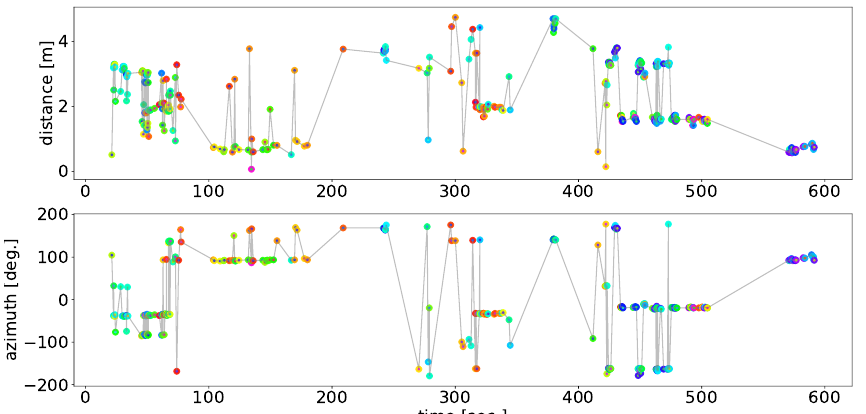
Figure 8. Spatial, temporal, and spectral dynamics of vocalization among ZF individuals. The top panel represents the temporal changes in the distance of localized sources from the microphone array 4. The bottom panel represents the temporal changes in the direction of the localization results from the microphone array 4. The colors of the dots correspond to the colors given in Figure 7.